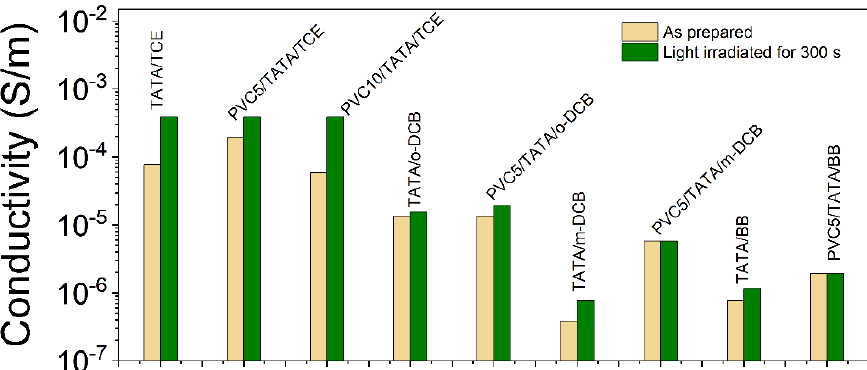
Figure 9. Conductivity in a log scale measured for different samples as indicated. Gray = freshly prepared and green = after 300 s light exposure. In all cases, C TATA = 1.5% ( w / w ), C PVC5 = 5% ( w / w ) and C PVC10 = 10% ( w / w ). The conductivity of PVC10% in TCE was about 10 − 6 S/m. Table 1. Values of the conductivity for different binary and ternary gels expressed in Siemens/m. Sample